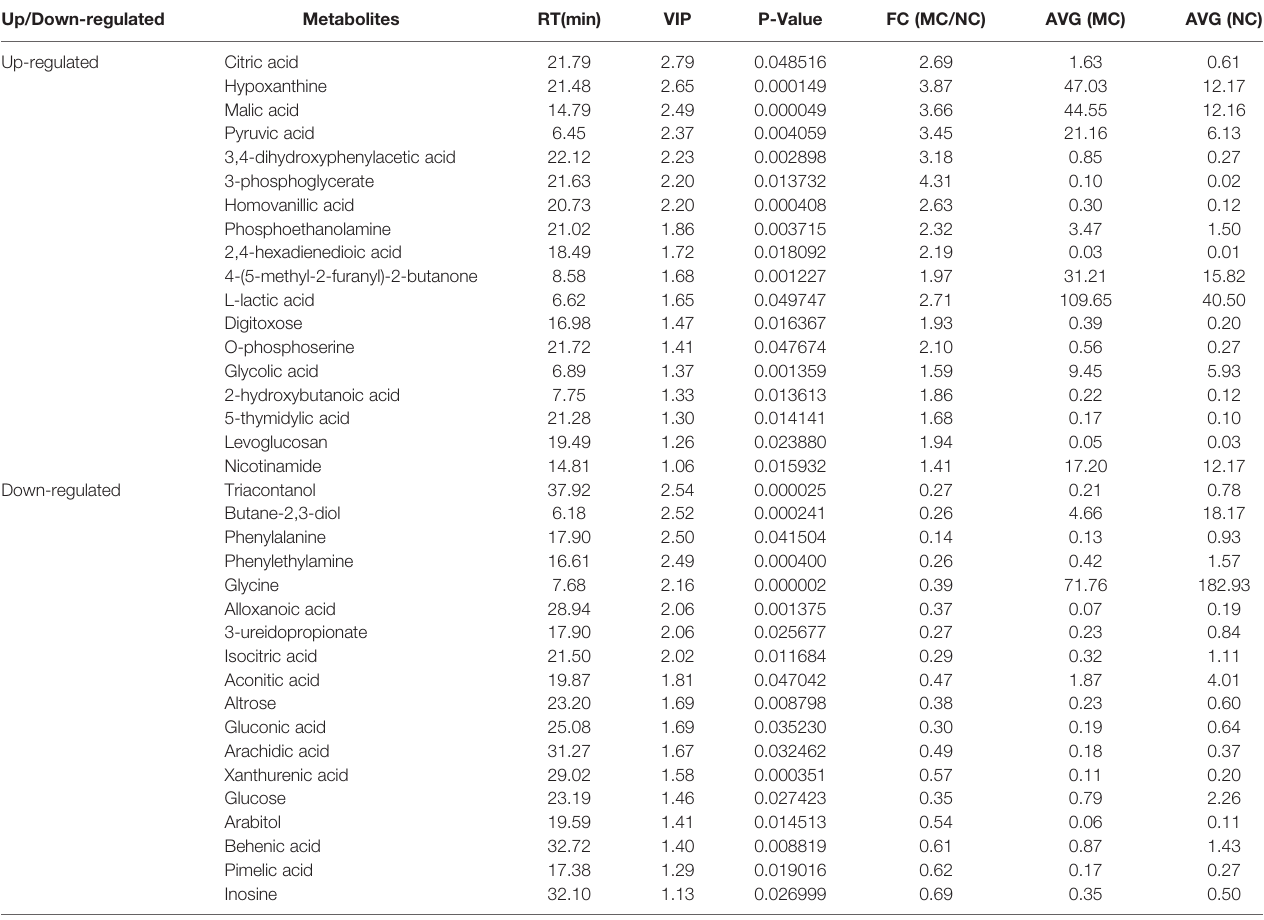
TABLE 3 | Signi fi cantly differential metabolites in gills of MCvsNC group.